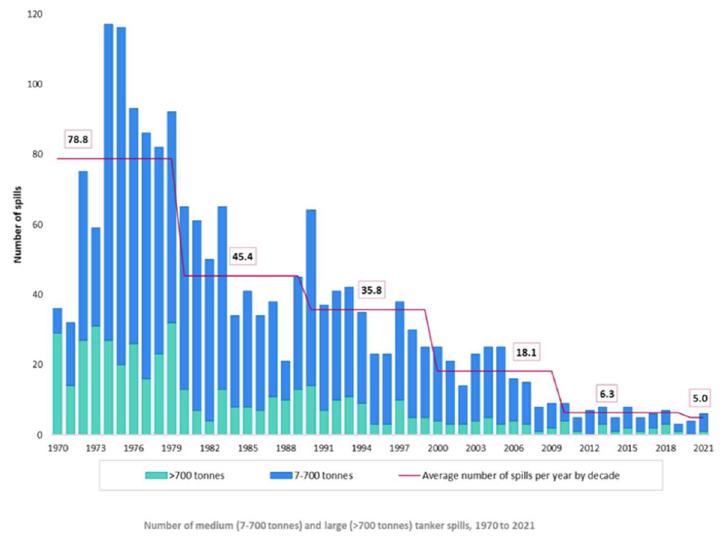
Figure 1. Number of medium and large tanker spills per year from 1970 to 2021. Repro- duced with permission from ITOPF, 2022